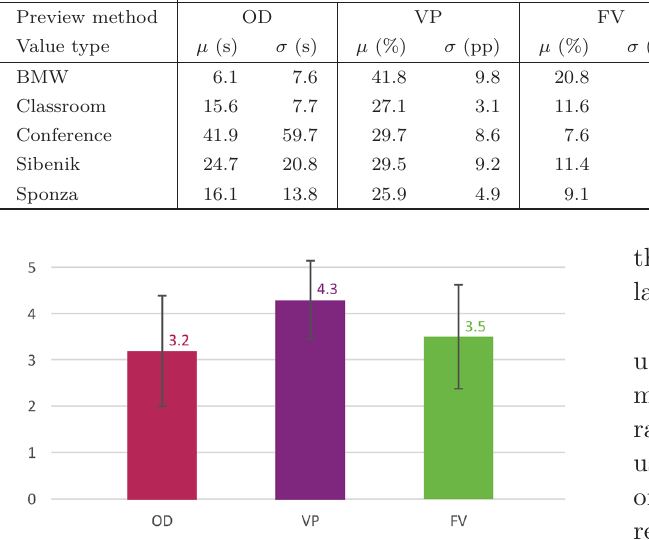
Table 2 Arithmetic mean ( μ ) and standard deviations ( σ ) of the measured time for each scene in the user study. The results of the FV (proposed) and VP methods are compared to OD; pp stands for percent point. Large values of σ in OD are caused by the participants selecting different kinds of objects Timing type